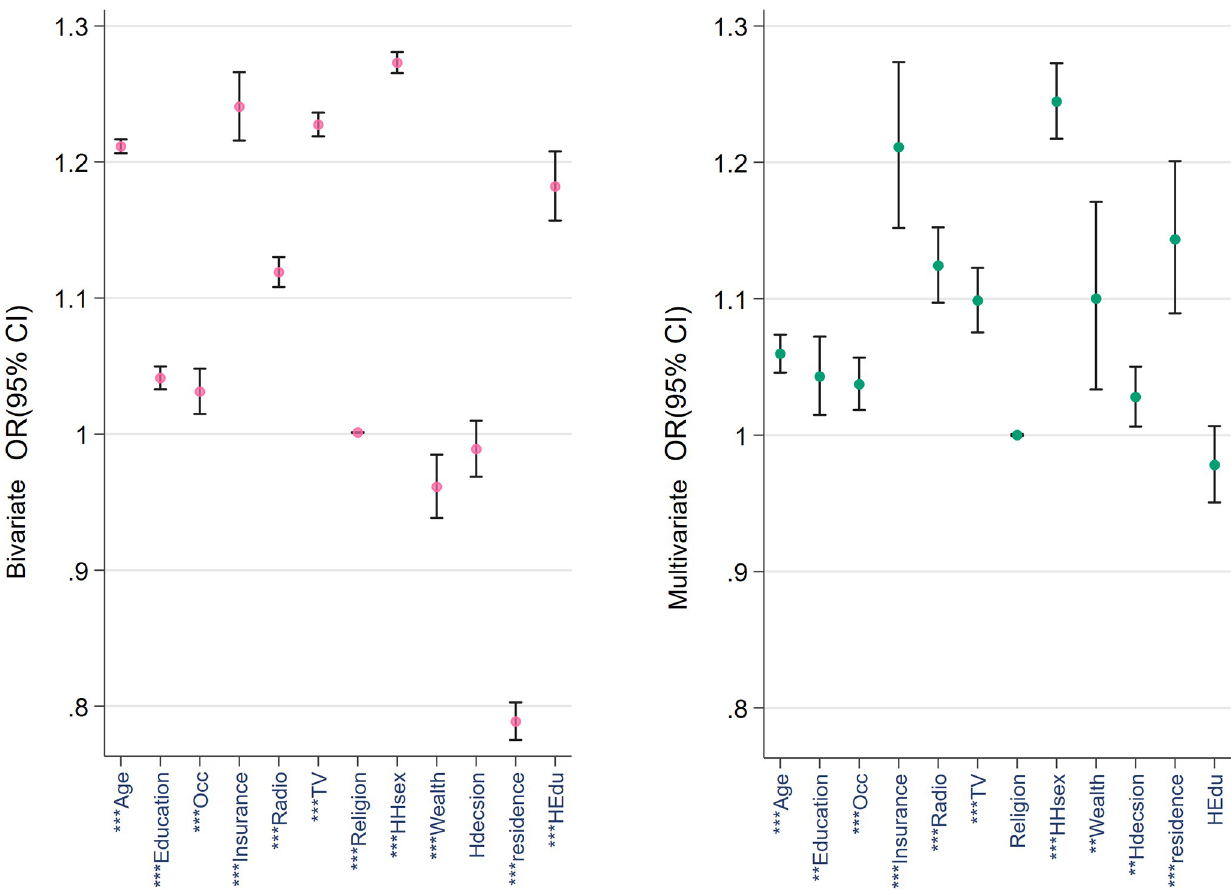
Fig 2. Bivariable and multivariable correlation among breast screening and the covariables. N.B.: � p < 0.05, �� p < 0.01, ��� p < 0.001. HHsex = household head’s sex; Hdecision = healthcare decision maker, HEdu = husband’s